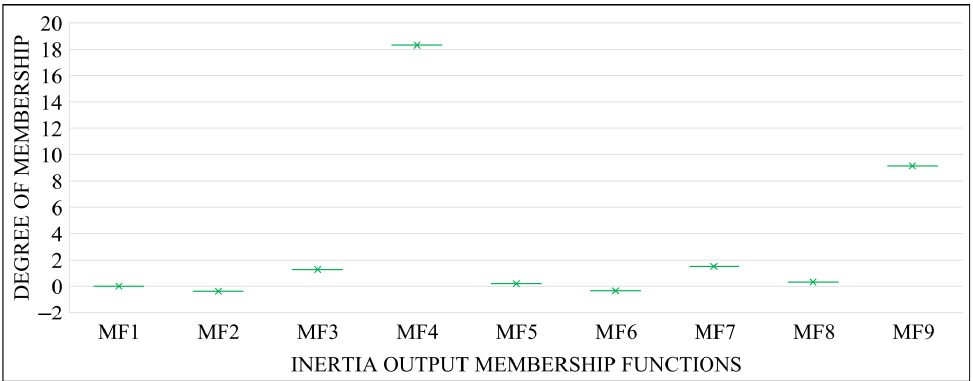
Figure 12. Output defuzzification membership functions of the inertia